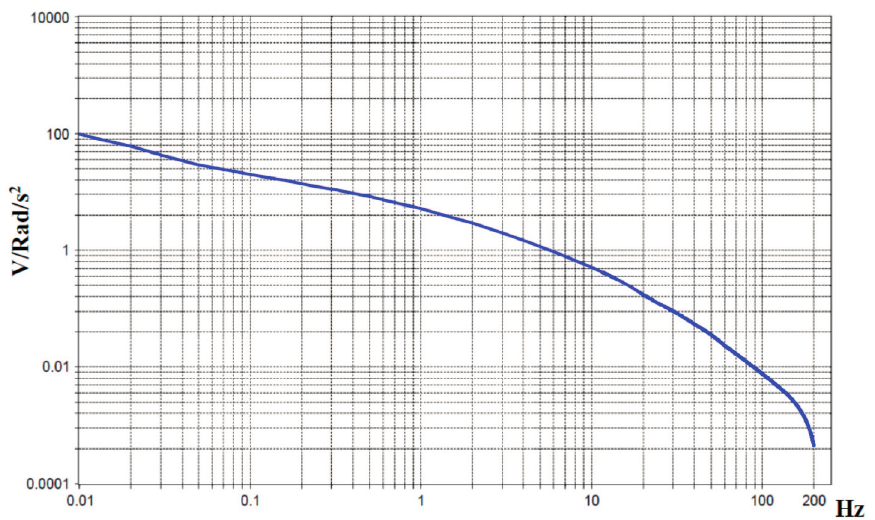
Figure 6. Experimental sensor conversion coefficient without frequency correction in units of angular acceleration. The Y-axis is the scale factor (V/Rad/s 2 ), the X-axis is the frequency in